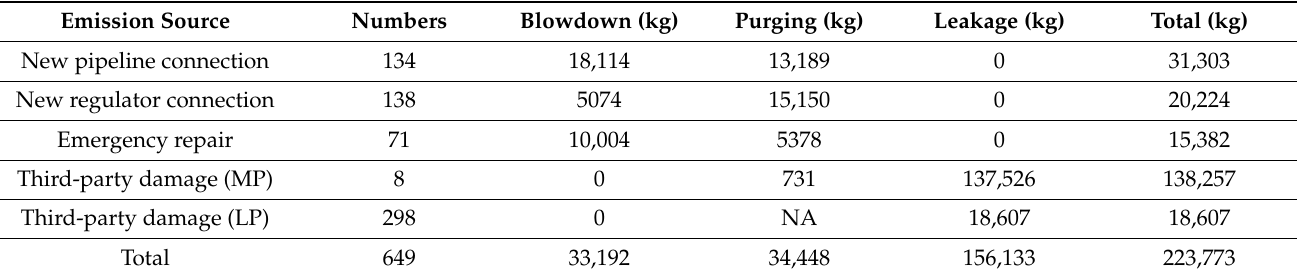
Figure 10. Distribution of methane emission rate from third-party damage. Table 1. Methane emission